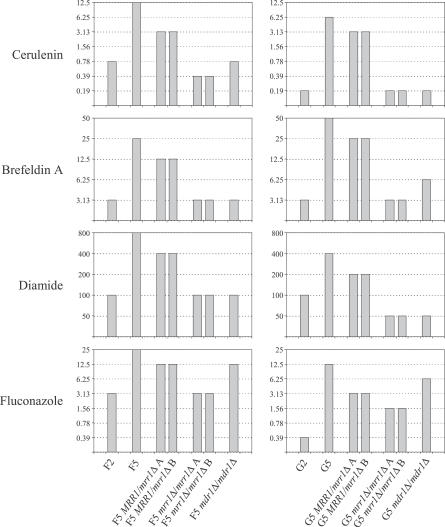

MRR1 Mediates Drug Resistance of MDR1 Overexpressing Clinical C. albicans IsolatesMinimal inhibitory concentration (MIC) of the indicated metabolic inhibitors (in μg ml−1) for the drug-sensitive clinical isolates F2 and G2, the matched drug-resistant isolates F5 and G5, and two independently constructed heterozygous and homozygous mrr1Δ mutants as well as mdr1Δ mutants of the drug-resistant isolates F5 and G5. The susceptibilities of the isolates F2, F5, and its mutant derivatives are shown in the left panels, and those of isolates G2, G5, and its mutant derivatives are shown in the right panels.